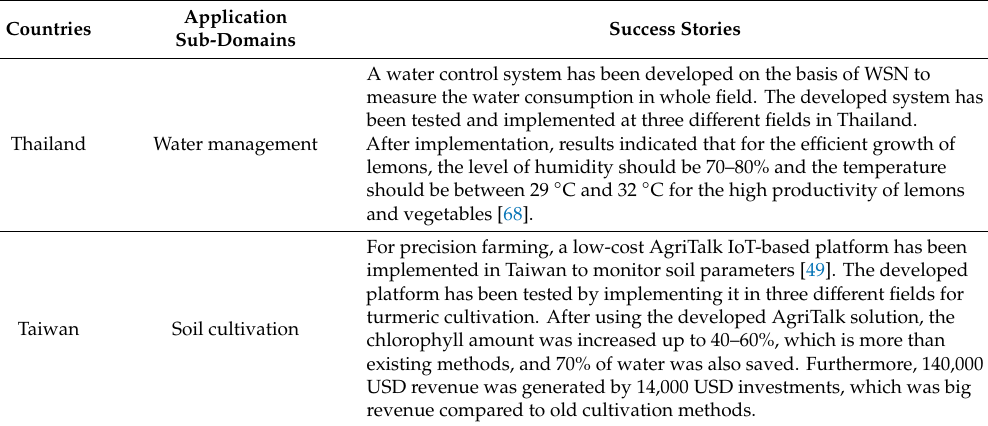
Table 8. IoT-based agriculture success